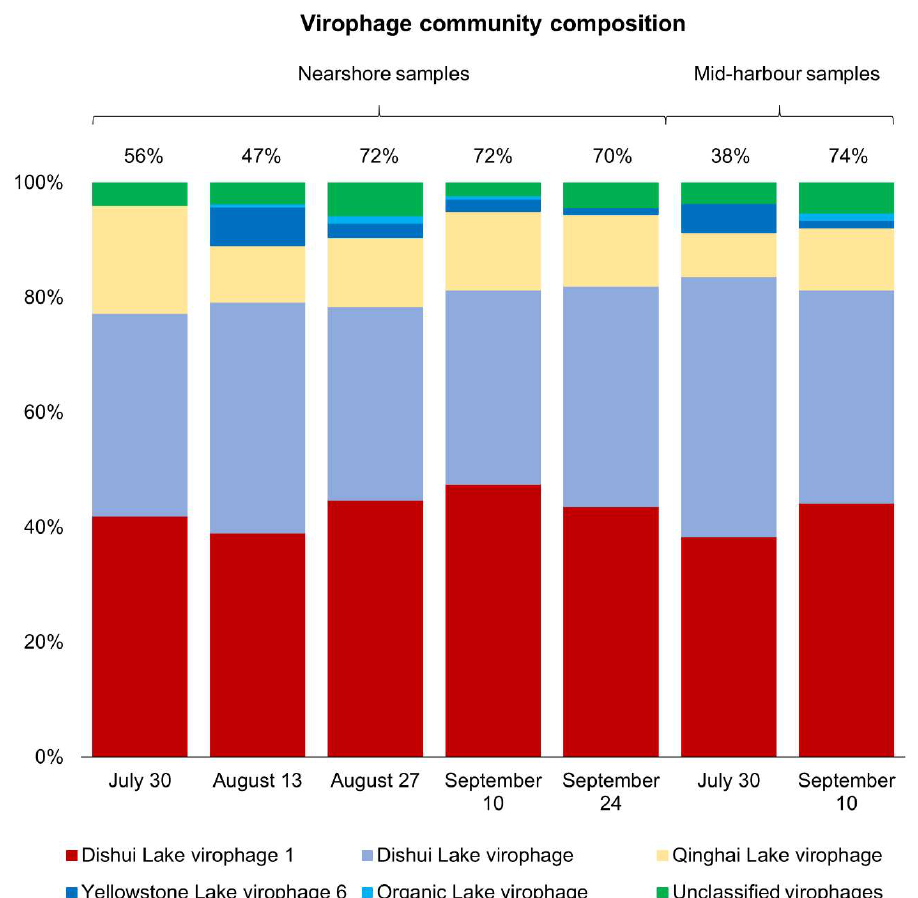
Figure 5. Virophage community composition in samples where virophages represent > 10% of the total virus community. Numbers above bars are percentages of the total virus community that the entire bar represents.